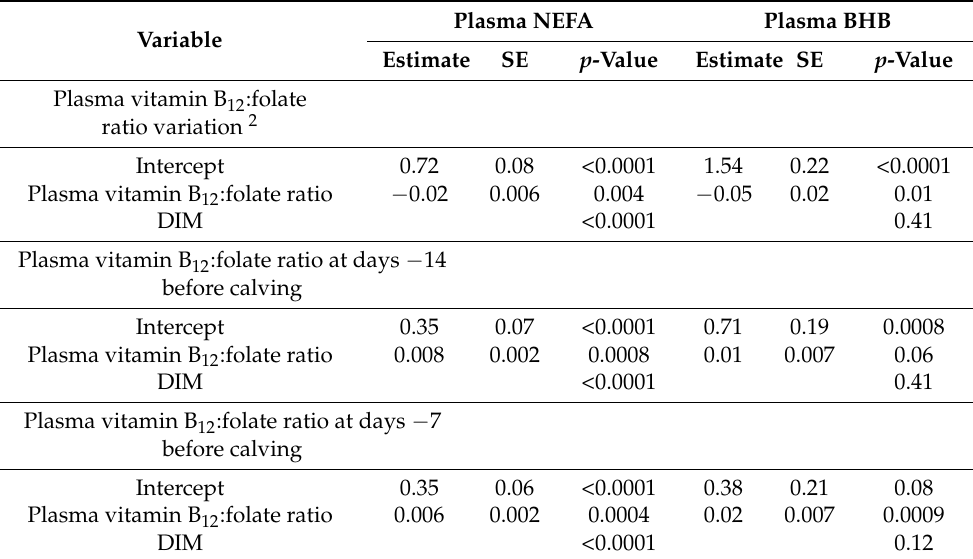
Table 5. Relationships between postpartum plasma NEFA and BHB concentrations 1 and prepartum plasma vitamin B 12 :folate ratio and its variation from − 14 to 21 DIM.